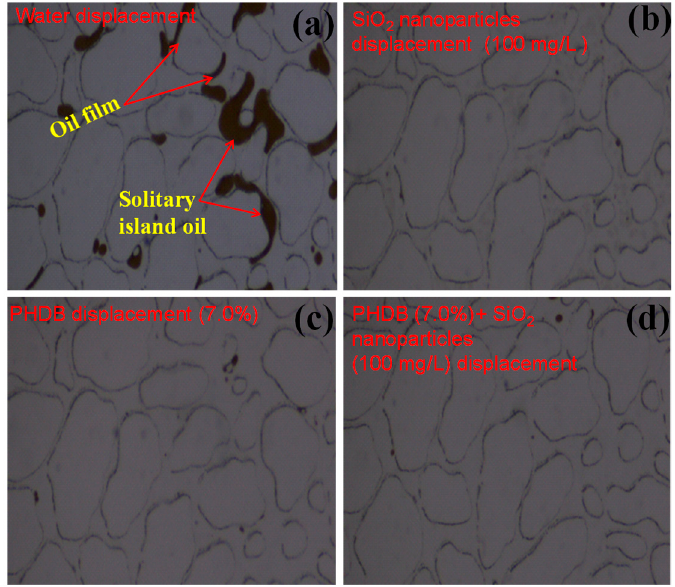
Figure 4. Mobilization characteristics of residual oil in middle channel areas under different displacement fluids. ( a ) After water flooding, ( b ) 100 mg/L of SiO 2 nanoparticle displacement, ( c ) 7.0% of PHDB displacement, and ( d ) PHDB (7.0%)-SiO 2 nanoparticles (100 mg/L) composite displacement.